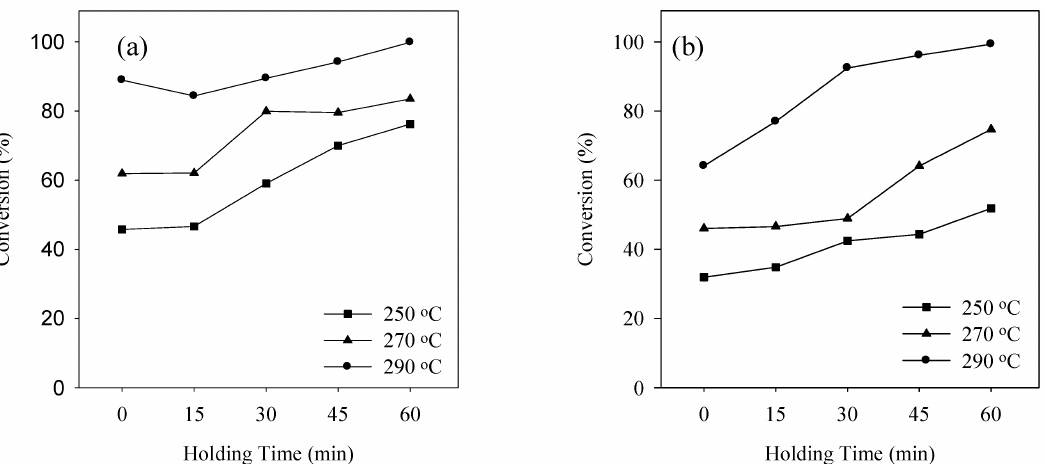
Figure 3. Conversion at various reaction temperature using ( a ) SCM and ( b ) SCE for waste pig fat to alcohol ratio of 1:2.0.